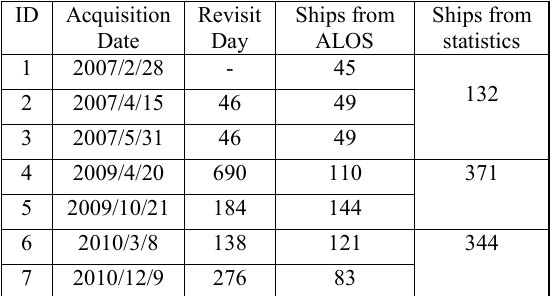
Table 3. Total number of recycling ships analysis by ALOS imagery of ship breaking yards around Alang